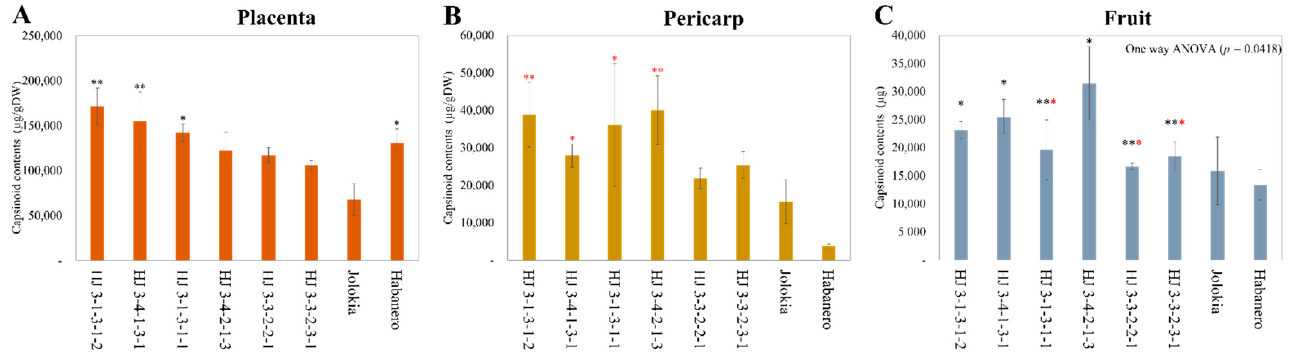
Figure 3. Capsaicinoid contents of the placenta ( A ), pericarp ( B ), and fruit ( C ) in the ‘HJ’ F7 lines. Bars represent standard error ( n = 3). Black and red asterisks indicate a statistical difference from ‘BJ’ and ‘HB’ respectively, as revealed using a one–way ANOVA and Fisher LSD, with p –values between 0.001 and 0.01 showed with ‘**’, and lower than 0.05,